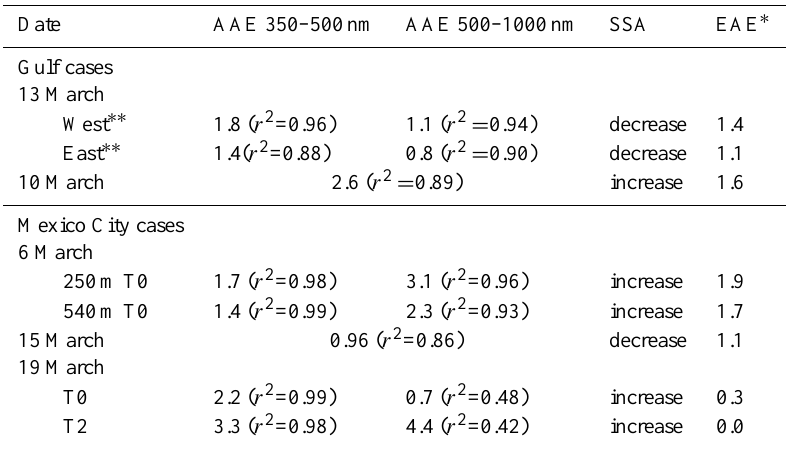
Table 1. Retrieved aerosol optical